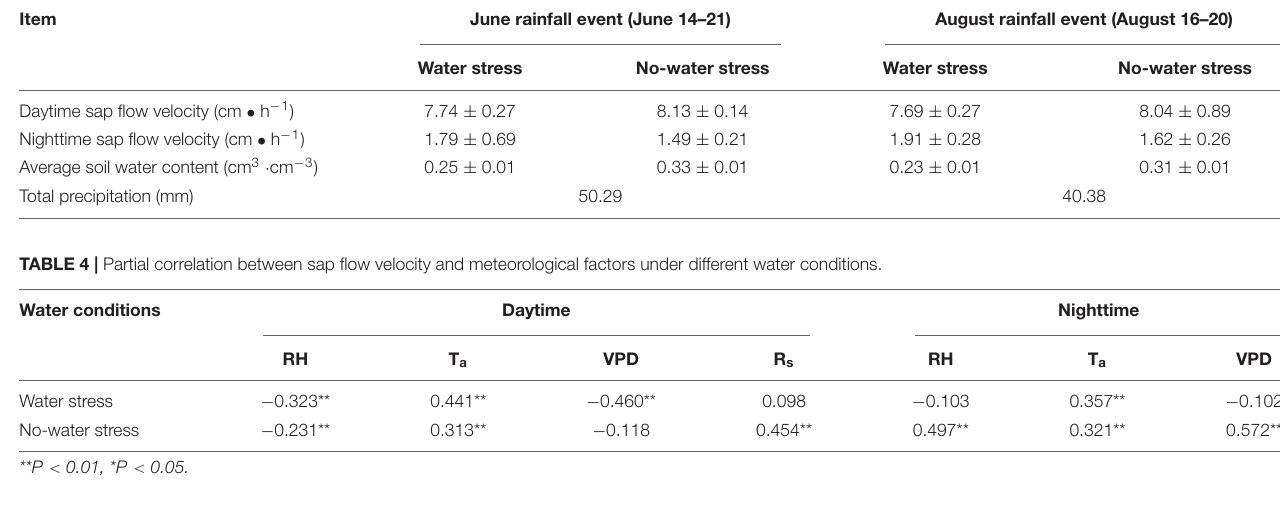
TABLE 3 | Relationship between daytime and nighttime sap flow velocity under different water conditions.